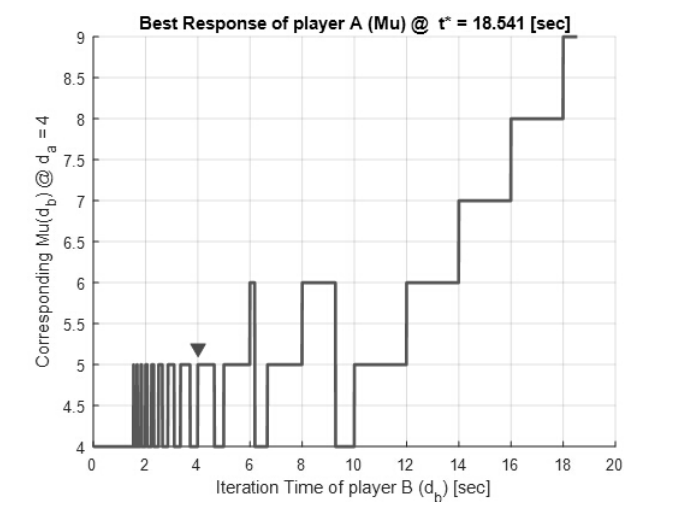
Figure 4. Best response function of Player A in the conventional duel game.